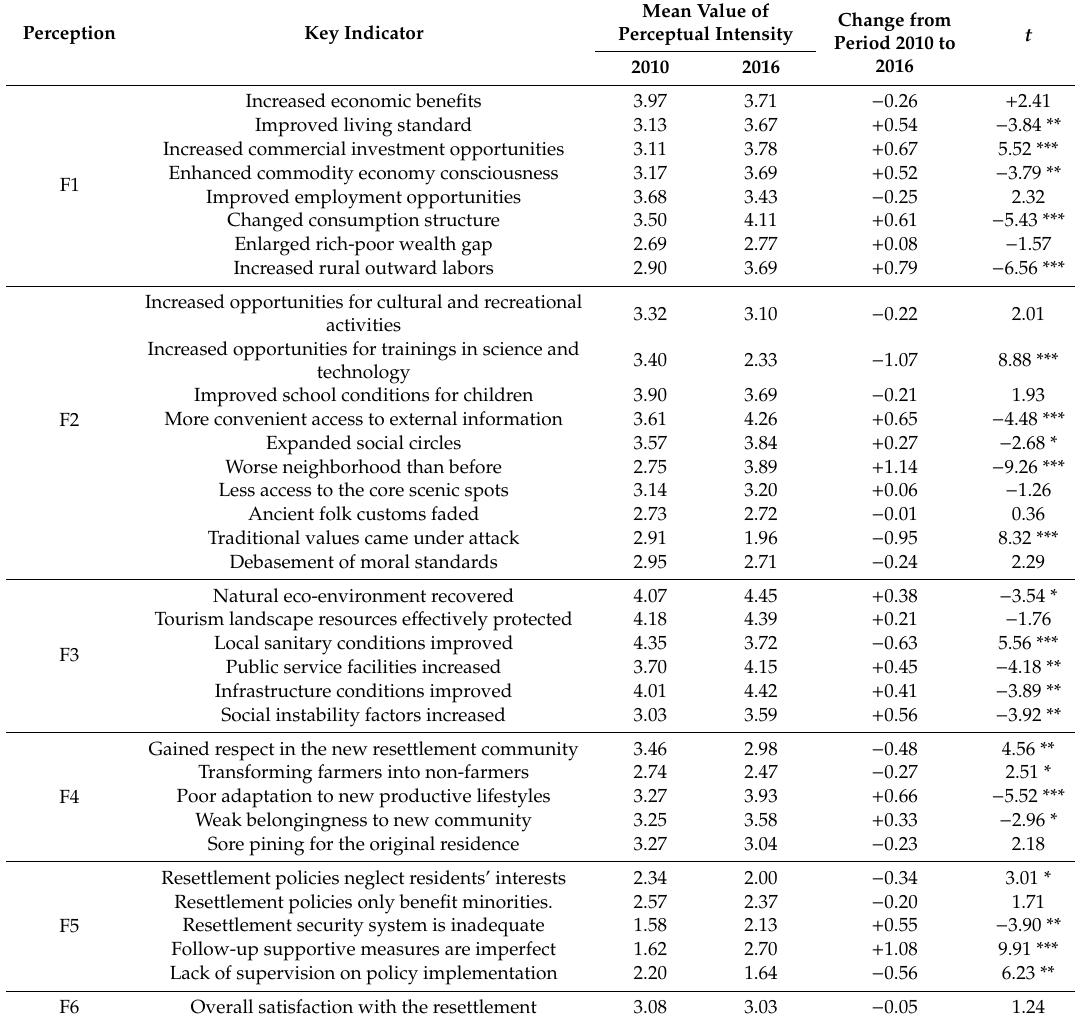
Table 2. Independent sample t -test of residents’ perception of impacts of ecological